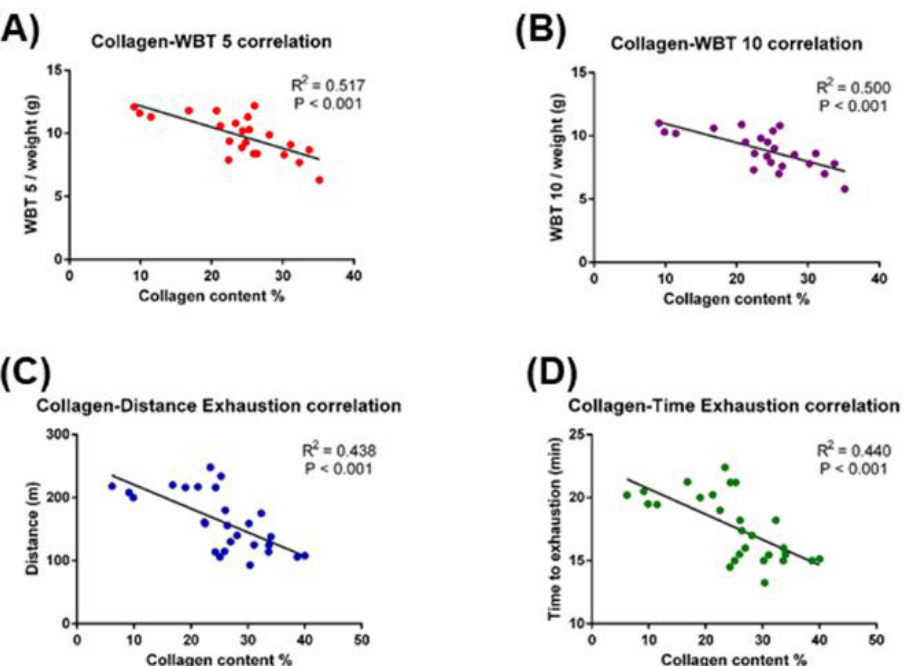
Figure 3. Correlation between muscle (DF) collagen content and physical performances of 5-month- old mdx mice. Collagen percentage was correlated to: WBT 5 and WBT 10 ( A , B ); distance ran and time to exhaustion in the treadmill exhaustion test ( C , D ). Pearson correlation coefficients are displayed.